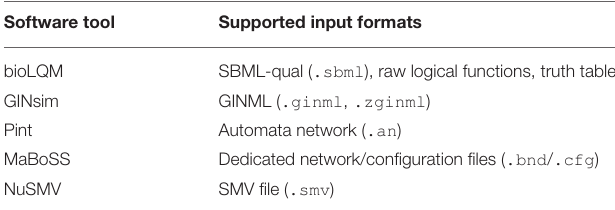
TABLE 1 | Model input formats for the software tools included in the CoLoMoTo Docker image. Software